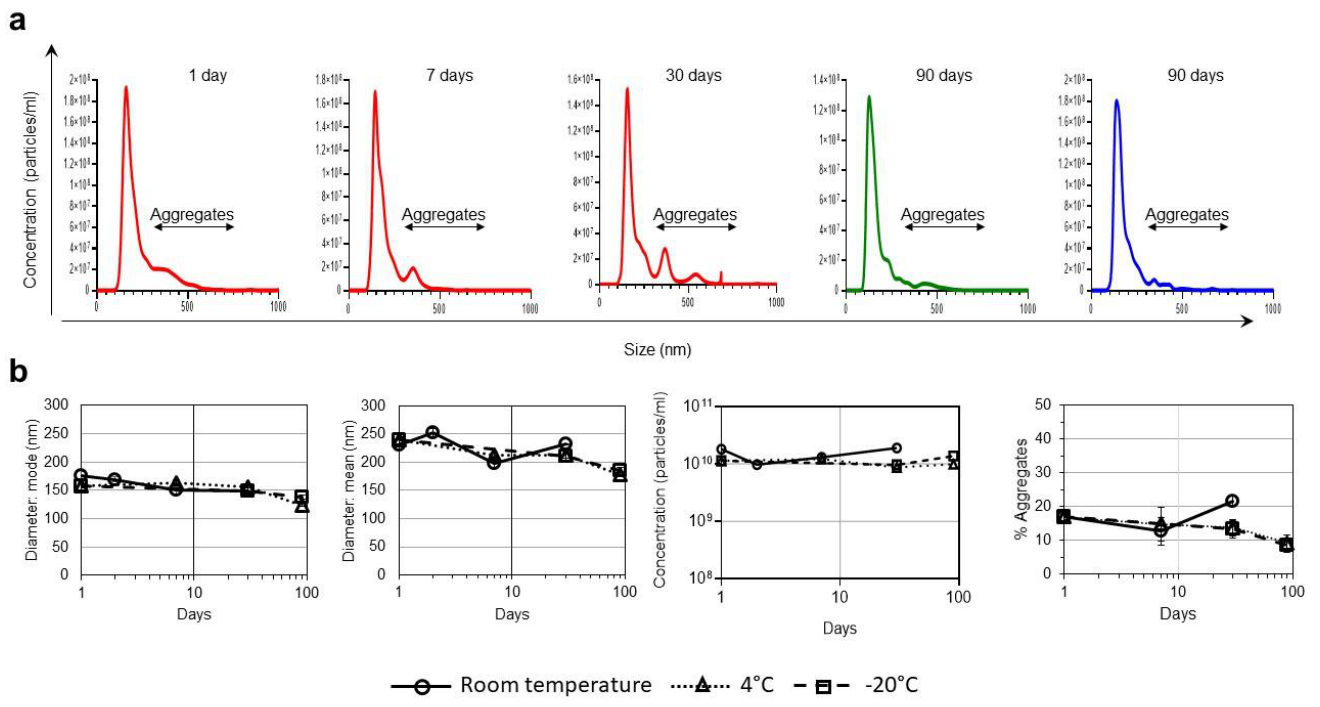
Figure 1. Effect of different storage temperatures in VLPs size and integrity. ( a ) Particle sizes and population distribution after 1, 7, and 30 days of storage at room temperature (red line); 90 days of storage at 4 ◦ C (green line) and 90 days of storage at -20 ◦ C (blue line) monitored by NTA. Black arrows identify the population of aggregates >300 nm. ( b ) Particle diameters (average mode and mean values with the corresponding standard deviations), particle concentrations, and percentage of aggregates over time after storage at room temperature, 4 and − 20 ◦ C, monitored by NTA. Values are averages and standard deviations of the values obtained in the five